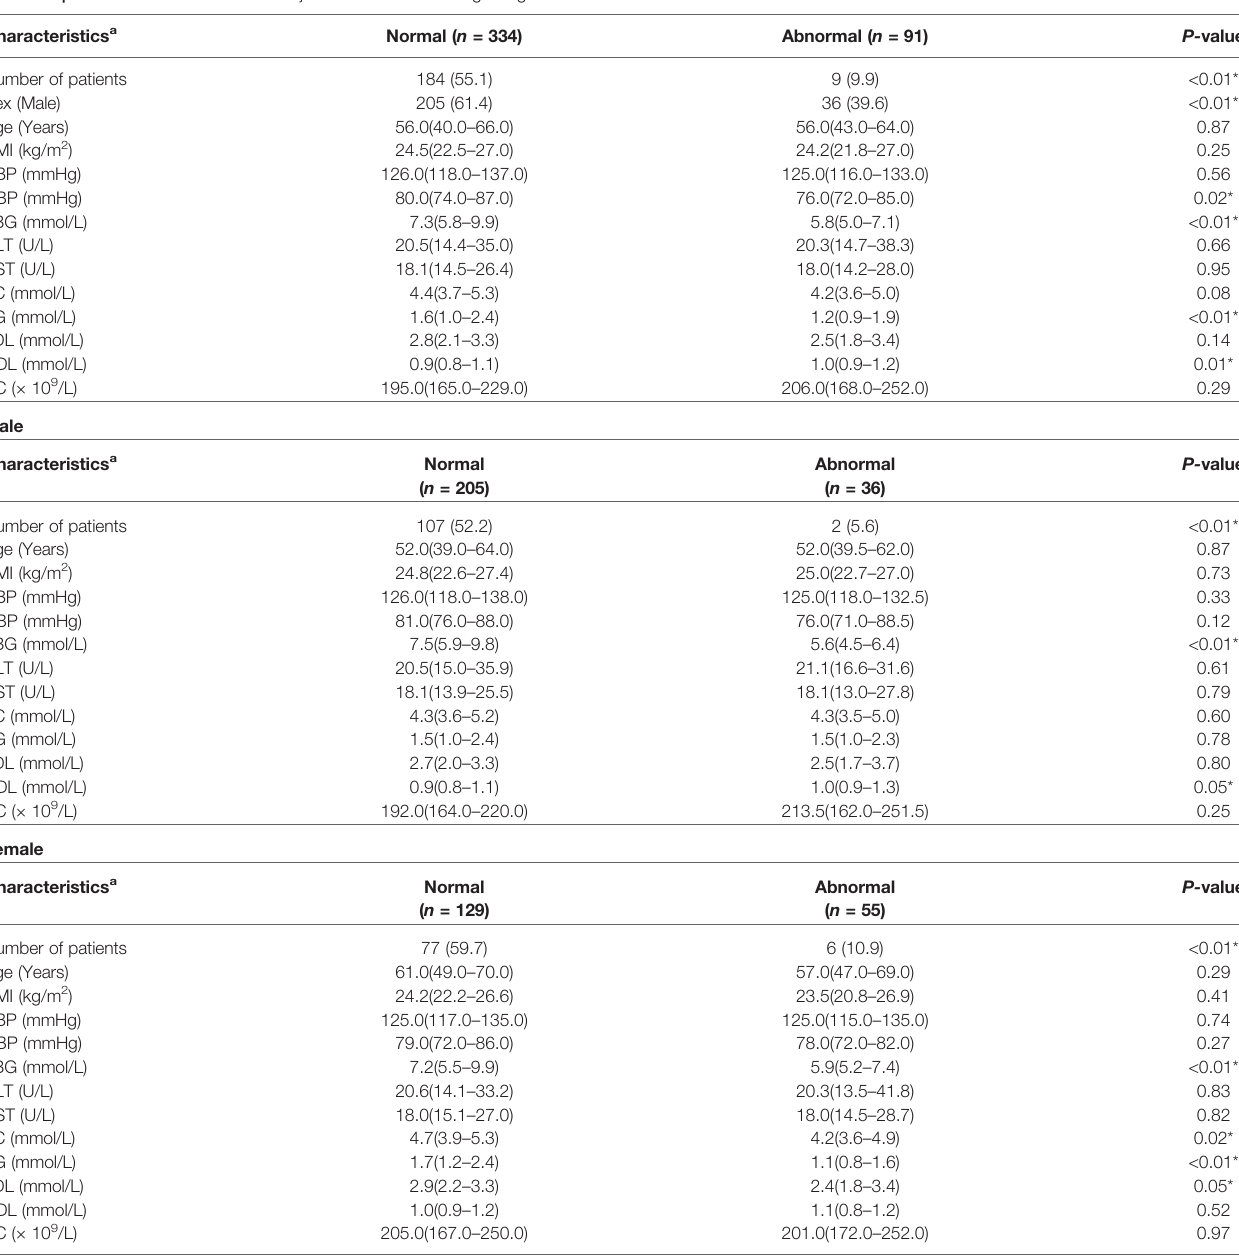
TABLE 3 | Baseline characteristics of subjects strati fi ed according to TgAb